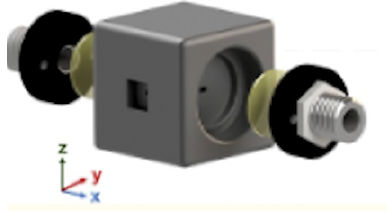
Figure 30. A modular 3D-printed waveguide. Adapted from [174], with the permission of AIP Publishing